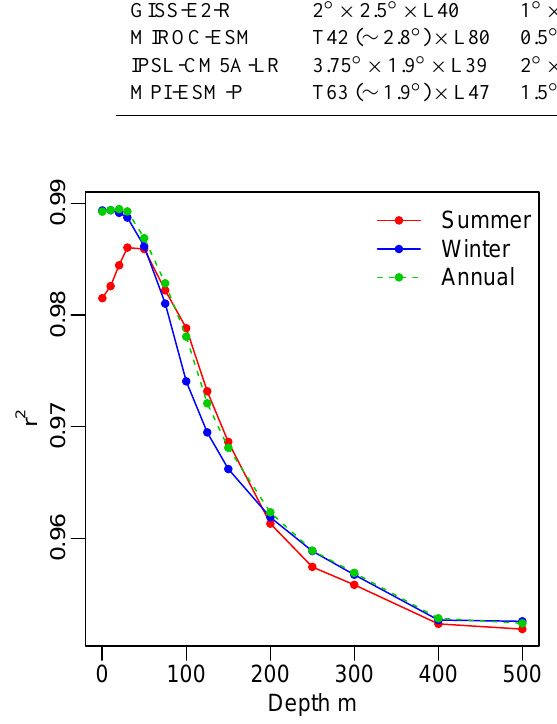
Fig. 2. Transfer function performance for the whole North Atlantic calibration set, shown as the r 2 between measured and predicted temperatures for different depths and